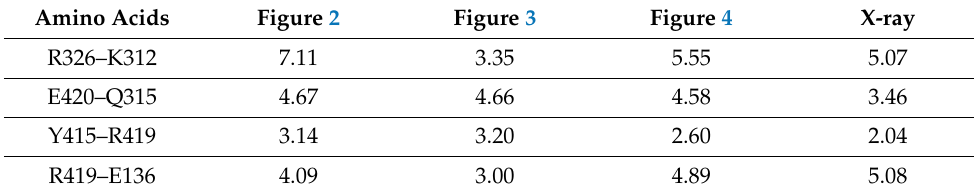
Table 2. Comparison of Certain Distances (Å) with X-ray Structure Distances *. Amino Acids Figure 2 Figure 3 Figure